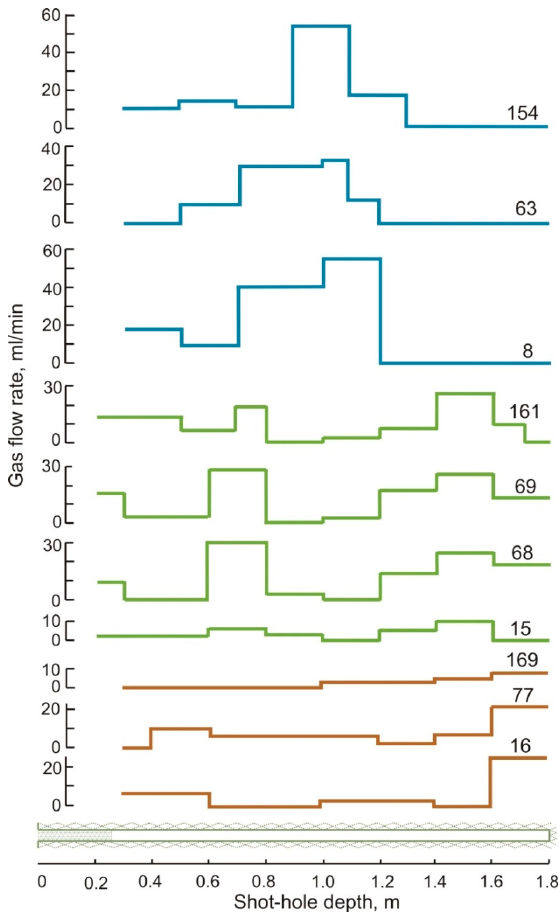
Figure 5. Temporal changes in the gas emission with depth along three (marked with different color) shot-holes in rocks of the Karnasurt site of the Lovozero loparite deposit. Numerals on the right are the number of days between drilling the shot-hole and the gas emission measurement (modified from [19]).